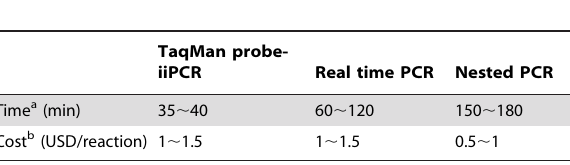
Table 3. Time and costs for TaqMan probe-iiPCR and relevant PCR